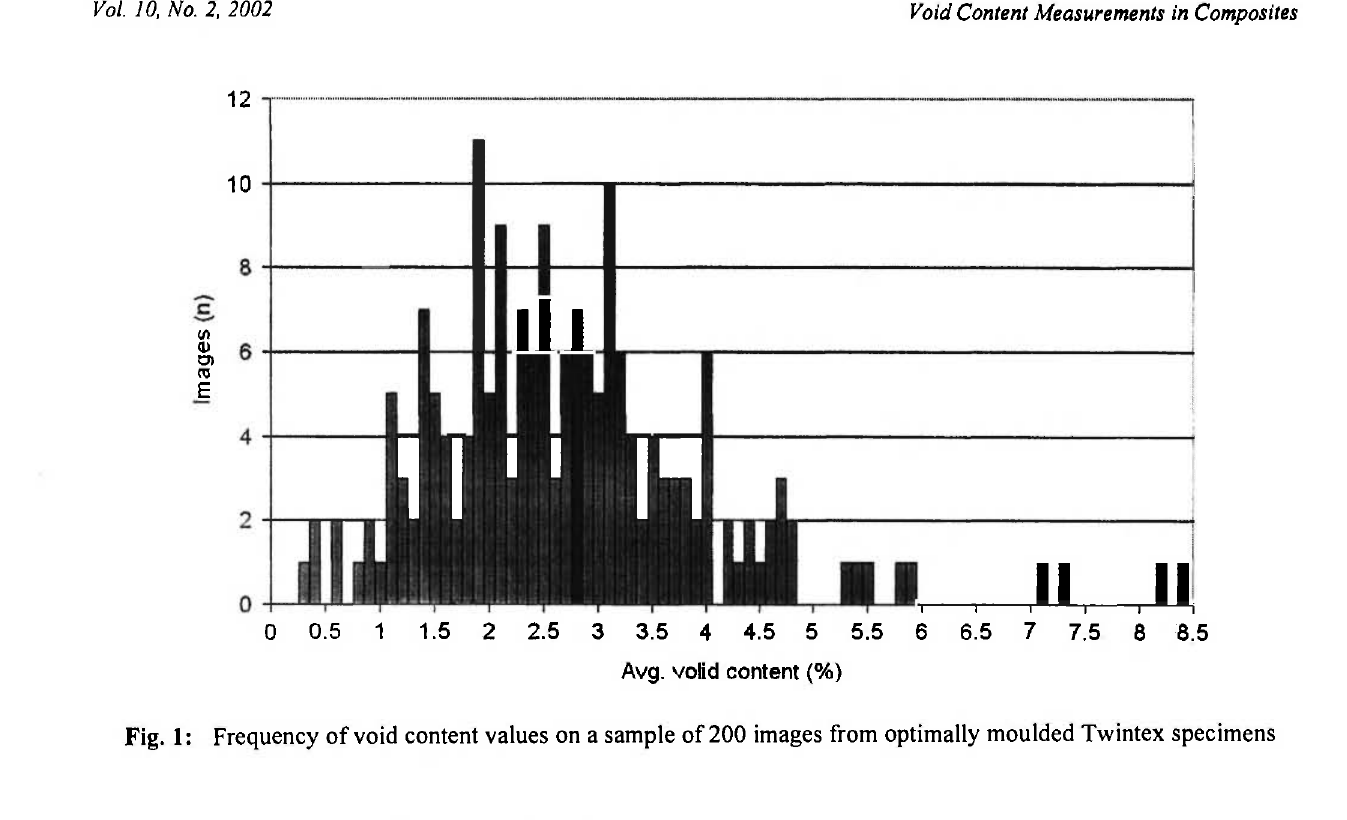
Fig. 1: Frequency of void content values on a sample of 200 images from optimally moulded Twintex specimens